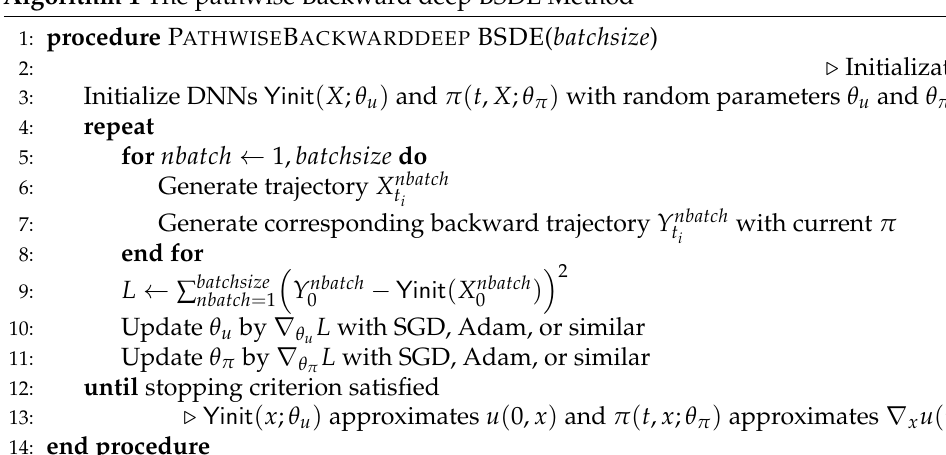
Figure 1. Computational graph for the entire method with initial network. Algorithm 1 The pathwise Backward deep BSDE